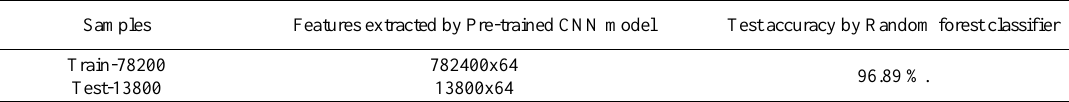
Table 5. Results using CNN features and random forest classifier